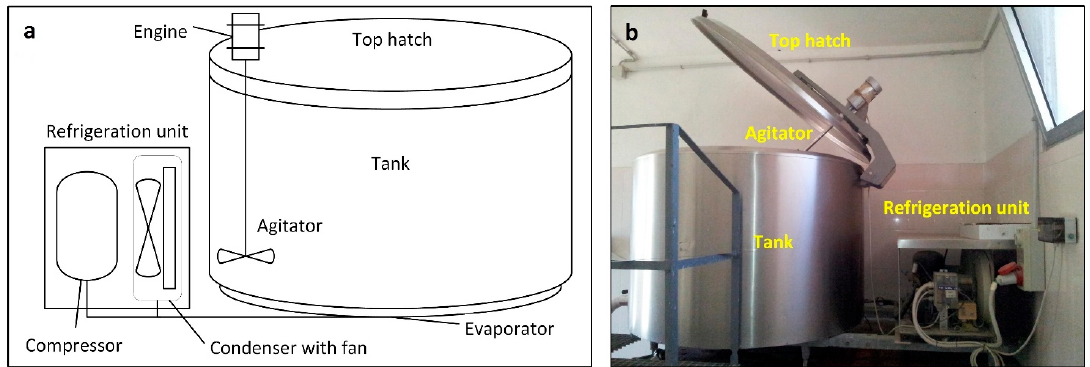
Figure 1. Scheme of a common milk cooling system used for sheep milk ( a ) and a real milk cooling system where the main components1 are highlighted ( b ). The energy consumption is mainly due to the compressor of the refrigeration unit and the agitator. Other minor absorptions are related to the control devices.